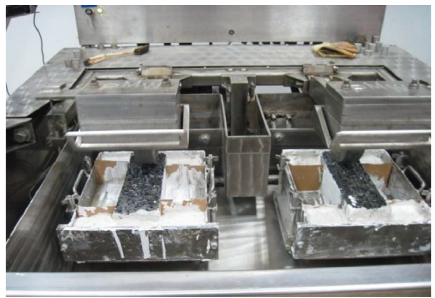
Figure 4: The process of the fatigue cracking test.